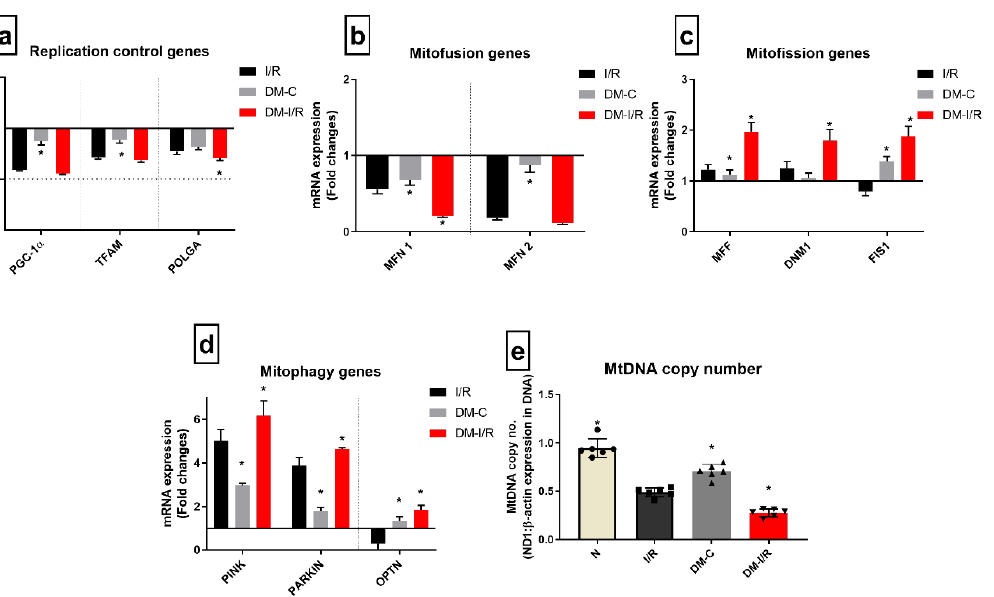
Figure 6. Impact of diabetes on the expression of mitochondrial dynamics genes during I/R: The mRNA expression of mitochondrial regulation control genes are presented as fold changes from the normal group for the processes of ( a ) mitochondrial replication; ( b ) mitofusion; ( c ) mitofission; ( d ) mitophagy; and the end effector ( e ) mitochondrial DNA copy number. The graphs represent mean ± SD values. * p < 0.05 vs. I / R